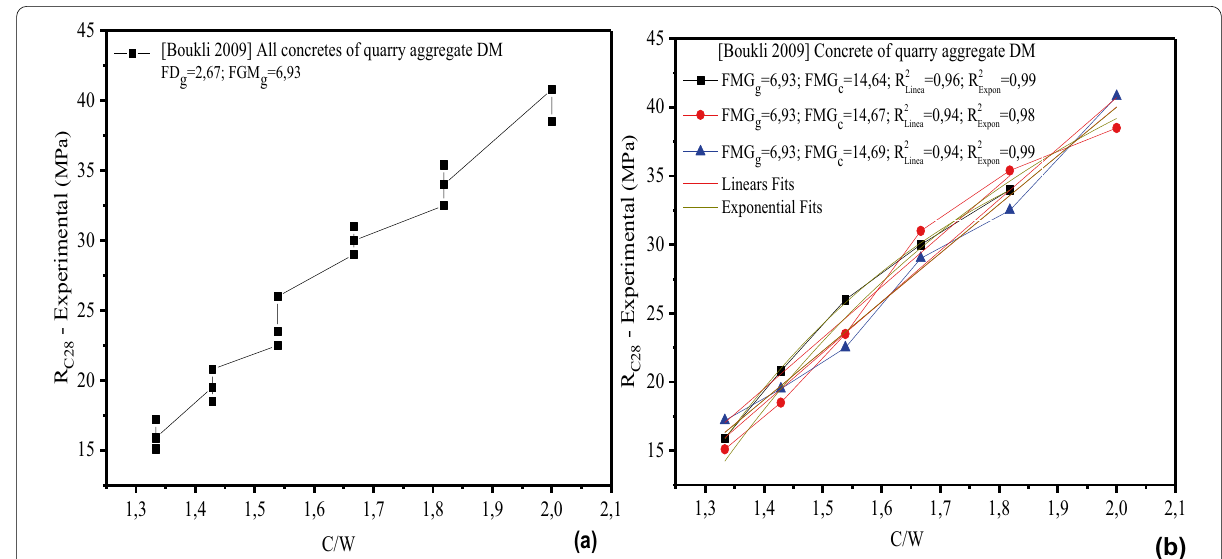
Fig. 13 Evolution of R C28 as a function of the ratio C / W the aggregate DM (Boukli et al. (2009). a Results of all concretes FD g and FGM g , b results given by the models FGM g and FGM C .